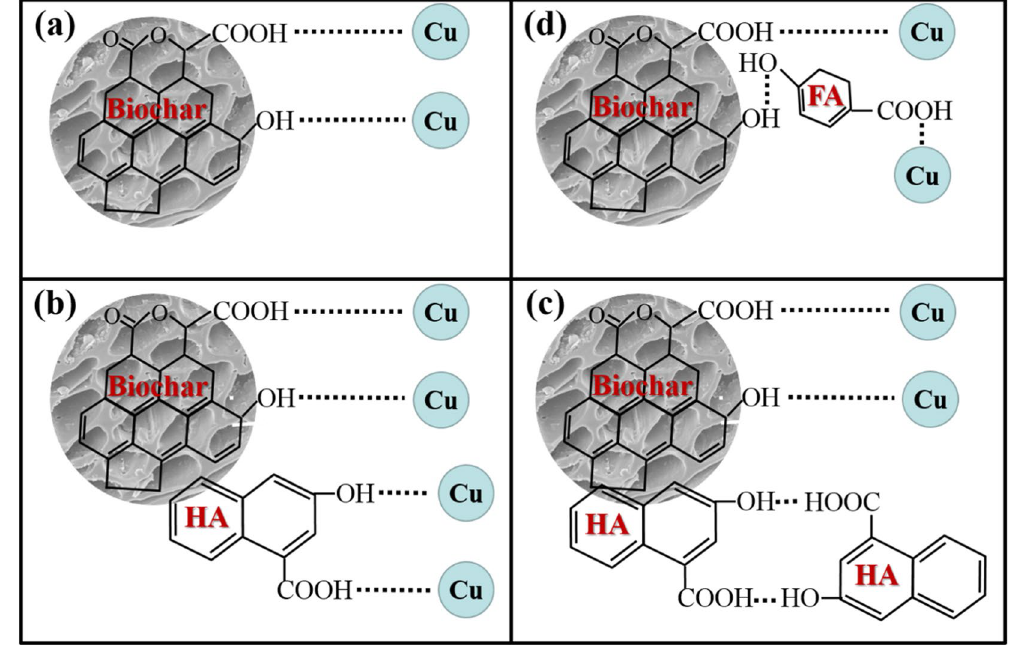
Figure 5. Schematic diagram of the interactions between Cu 2 + and ( a ) biochar; ( b ) low levels of HA-loaded biochar; ( c ) high levels of HA-loaded biochar; ( d ) FA-loaded